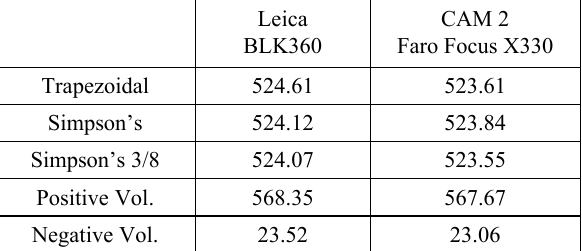
Table 4: Estimate of underground volumes